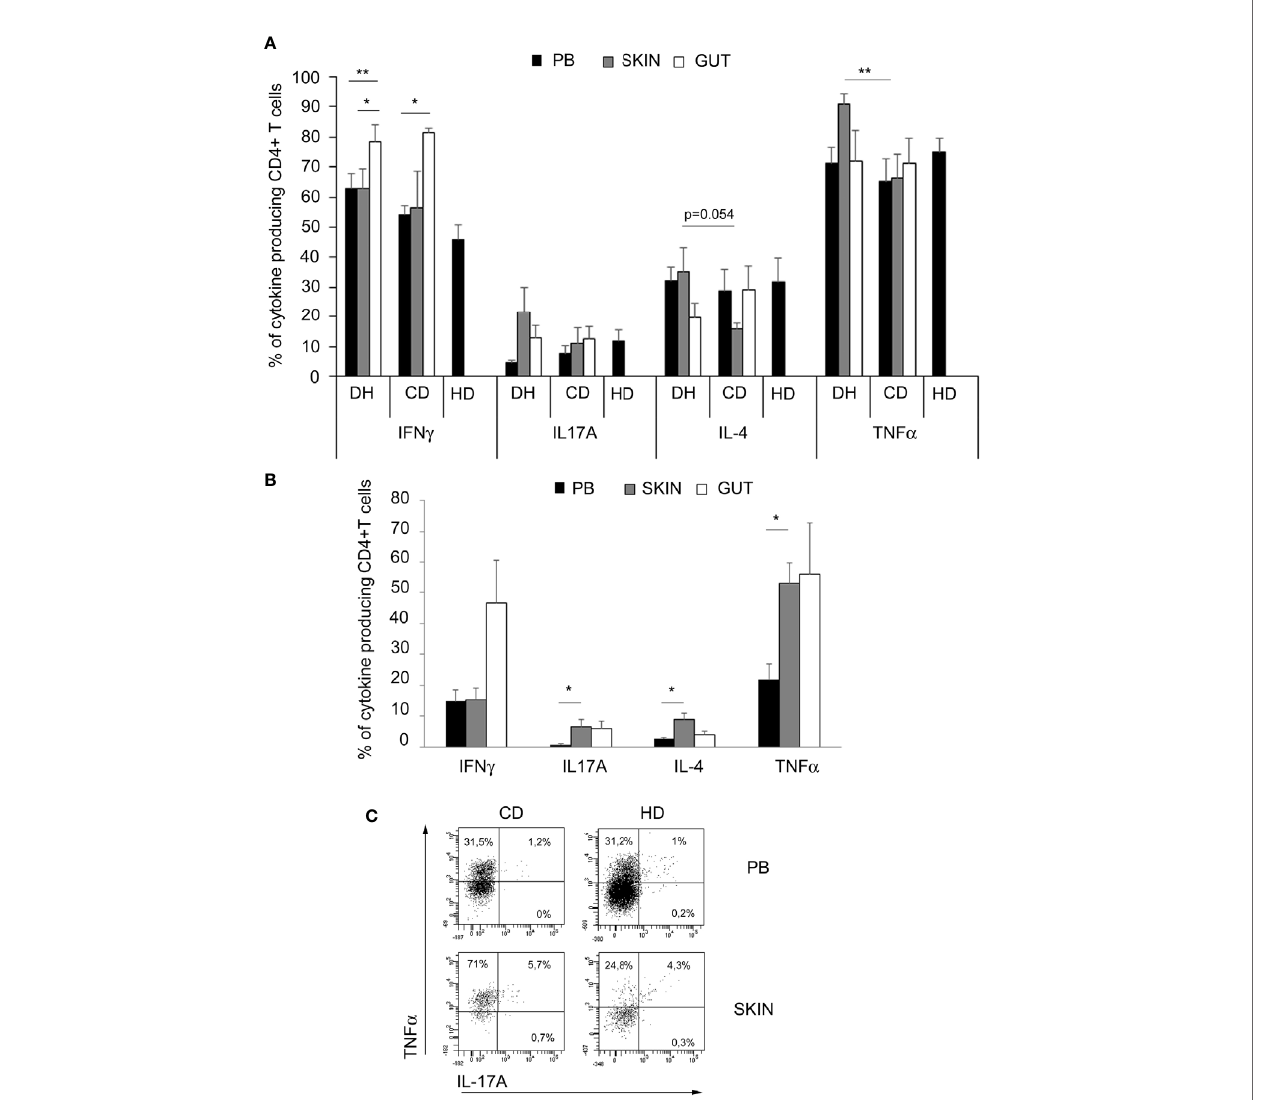
FIGURE 1 | TNF a -producing cells are enriched in skin samples from DH patients. (A) Intracellular cytokines production in in vitro expanded CD4+ T cells from PB (black columns), skin (grey columns) and gut (white columns): frequencies of cytokines producing of CD4+CD3+-gated cells were assessed in 10 DH patients, 6 CD patients and 4 healthy donors. Columns represent means ( ± SE). Bars * indicate p ≤ 0.05; bars ** indicate p ≤ 0.01. (B) Frequencies of intracellular cytokine producing CD4+ T cells in fresh samples from PB (black columns), skin (grey columns) and gut (white columns) of 5 DH patients. Columns represent means ( ± SE). Bars * indicate p ≤ 0.05. (C) Representative fl ow cytometric analysis obtained in one out of fi ve subjects with DH and in only one healthy specimen. Percentages of CD4+ T cells are shown. PB,peripheral